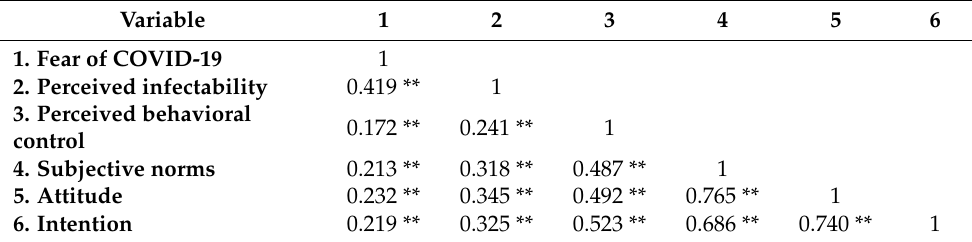
Table 2. The correlations of theory of planned behavior